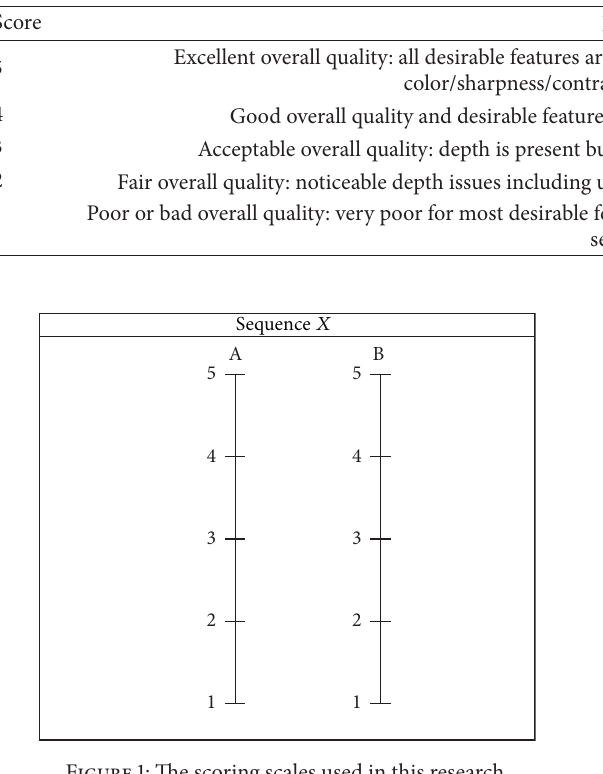
Figure 1: The scoring scales used in this research.